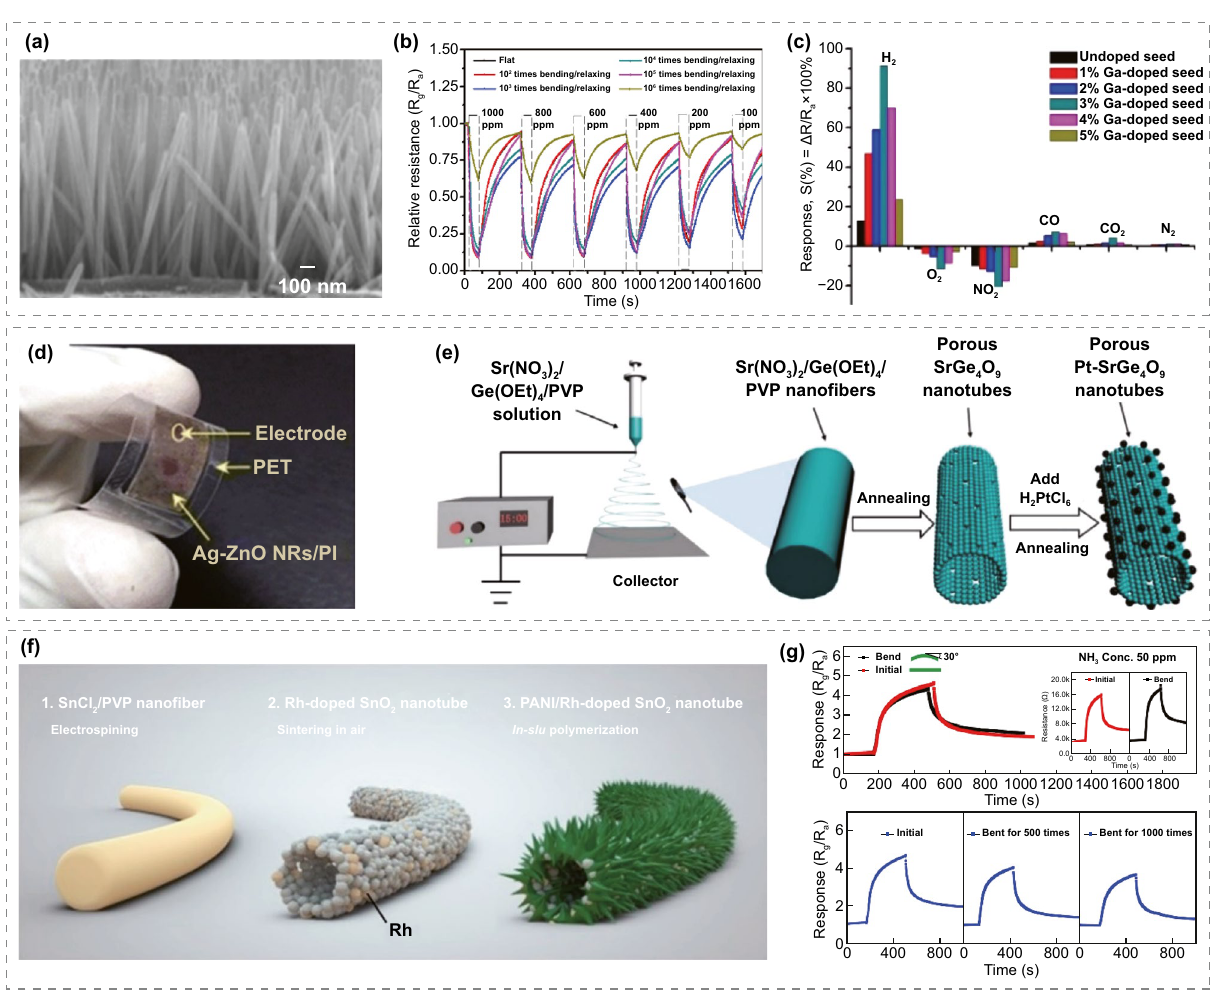
Fig. 3 a Cross‑sectional view of the Pd‑ZnO nanorods/PI/PET sensor after 1000 times bending/relaxing test. b The response, reliability test of Pd‑ZnO nanorods/PI/PET sensor. Reproduced with permission from Ref. [93]. Copyright (2013) Elsevier. c The selectivity of Pd–Ga‑ZnO nanorods/PI sensor for various Ga‑assisted seed layers conditions at 1000 ppm H 2 . Reproduced with permission from Ref. [91]. Copyright (2014) Elsevier. d The optical image of Ag‑ZnO nanorods/PI sensor. Reproduced with permission from Ref. [99]. Copyright (2018) Springer Nature. e Schematic illustration of the fabrication process of Pt‑SrGe 4 O 9 nanotubes. Reproduced with permission from Ref. [80]. Copyright (2018) Springer Nature. f Schematic illustration of the fabrication process of PANI/Rh/SnO 2 . g Response of PANI/Rh/SnO 2 sensors to 50 ppm NH 3 at RT under bending test. Reproduced with permission from Ref. [172]. Copyright (2021)